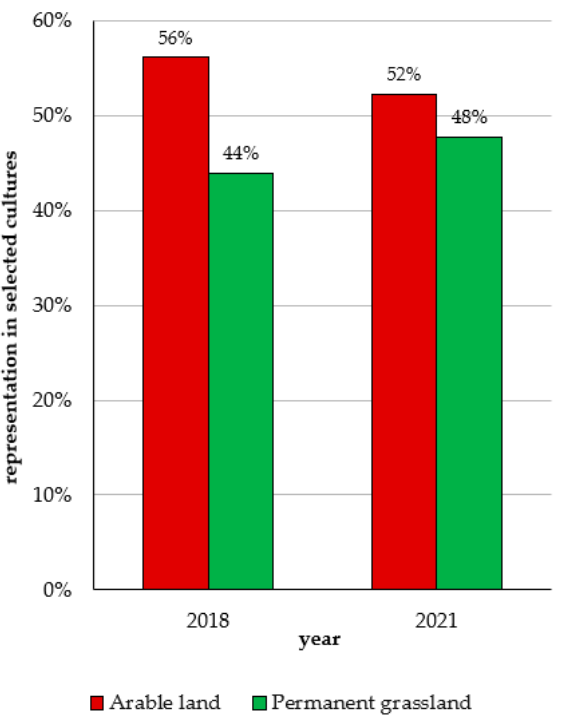
Figure 14. Changes in LPIS dataset for selected area: ( a ) 2018; ( b ) 2021.